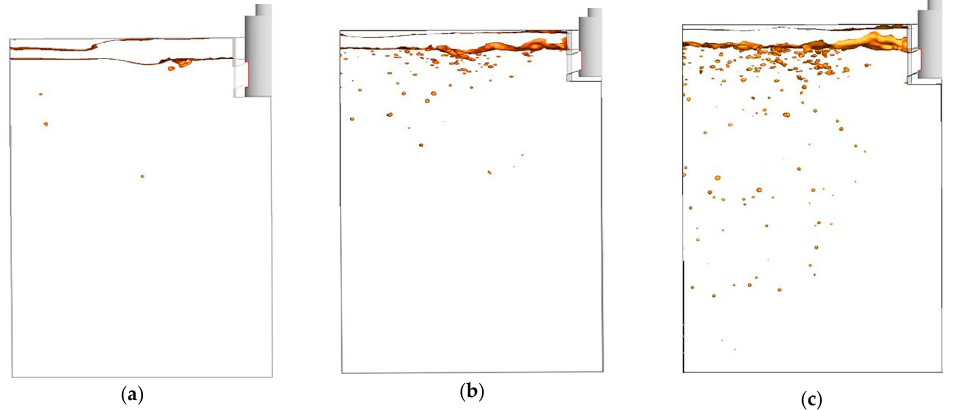
Figure 8. Slag droplets position at different times: ( a ) t = 5 s; ( b ) t = 10 s; ( c ) t = 15 s.